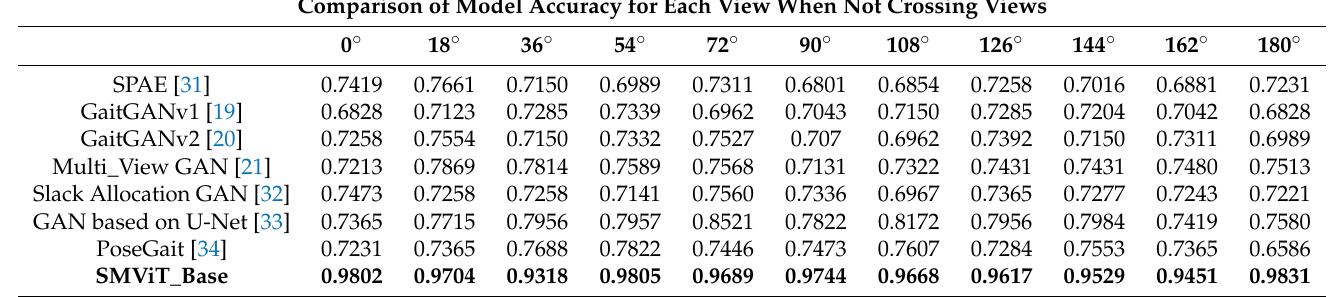
Table 2. Precision comparison of CASIA B with the latest technology for each view. Comparison of Model Accuracy for Each View When Not Crossing